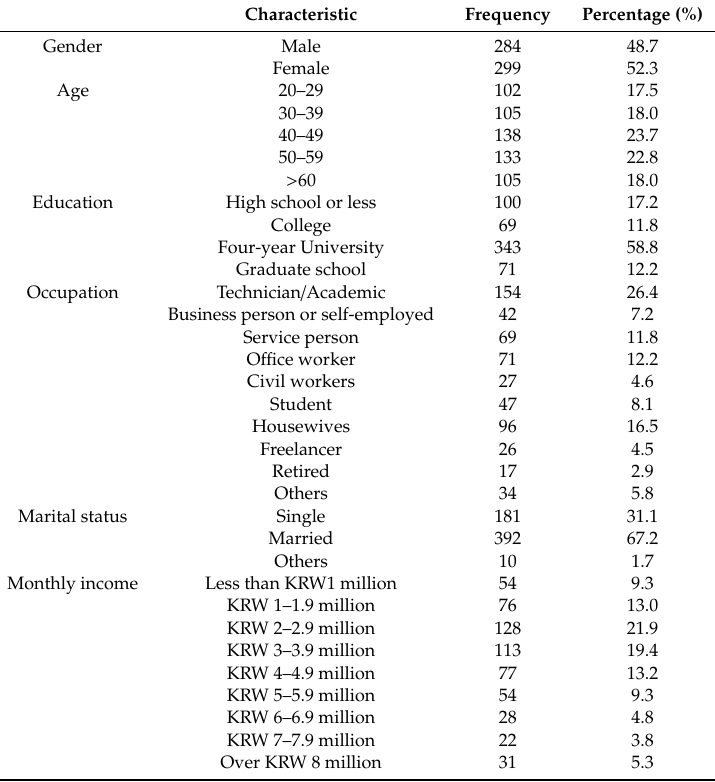
Table 1. Profile of survey respondents ( n =